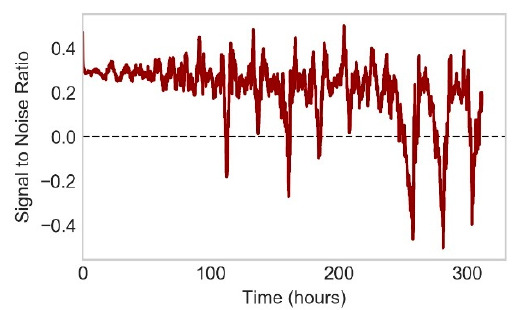
Figure 10. Signal to noise ratio (SNR) in TRT1.